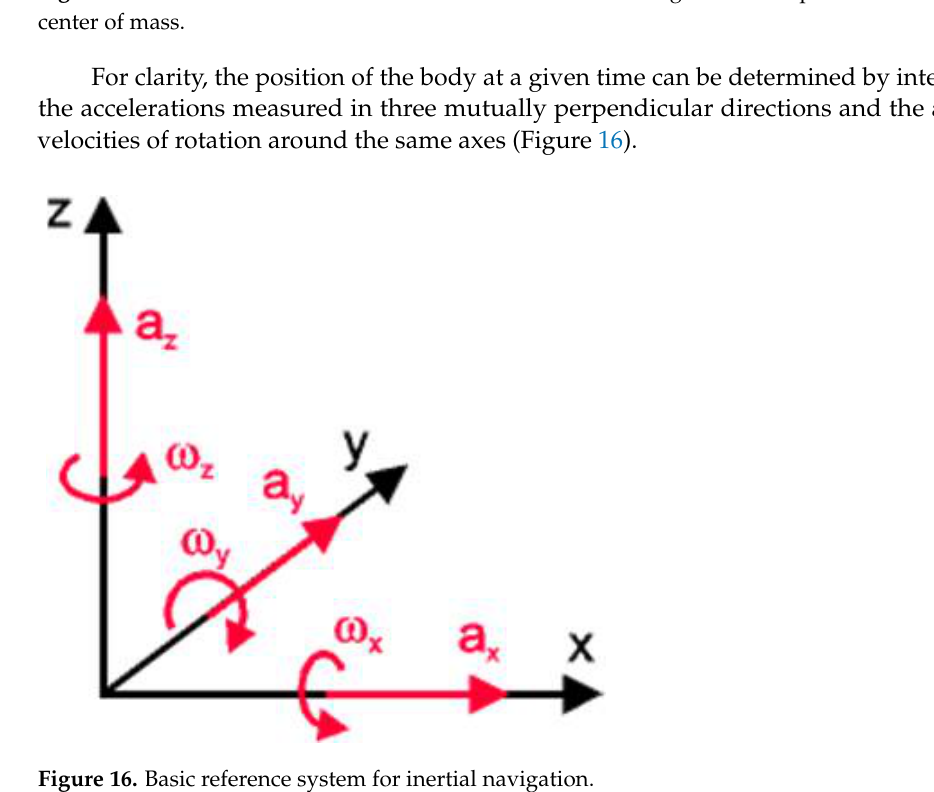
Figure 16. Basic reference system for inertial navigation.